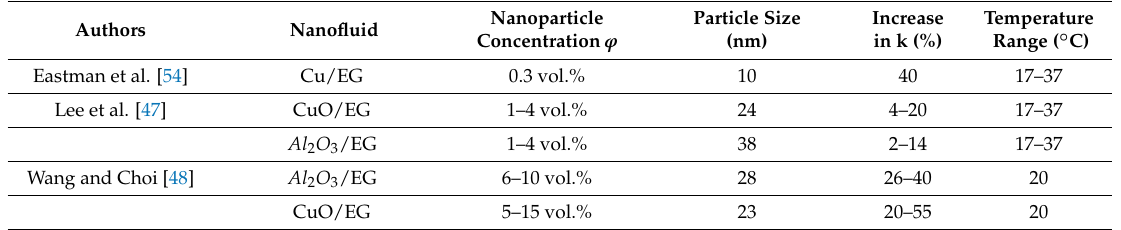
Table 4. Summary of the experimental data for the determination of the thermal conductivity of EG- and propylene-glycol (PG)-based